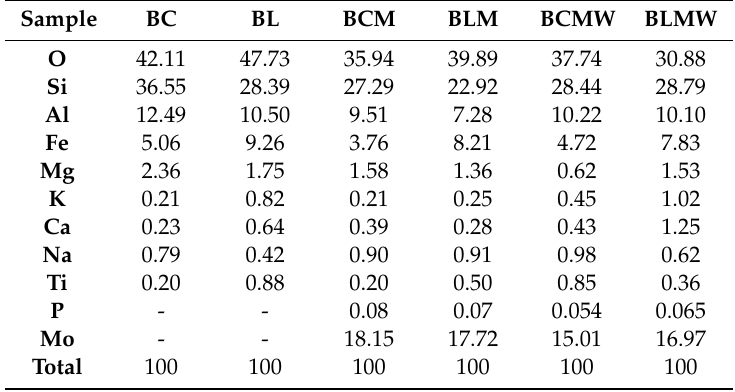
Table 1. Chemical compositions of samples in percentage